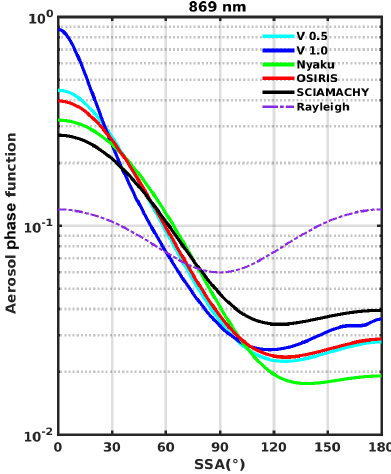
Figure 11. The aerosol phase function at 869nm as a function of SSA (or (cid:50) ) for the aerosol size distributions listed in Tables 1–2.